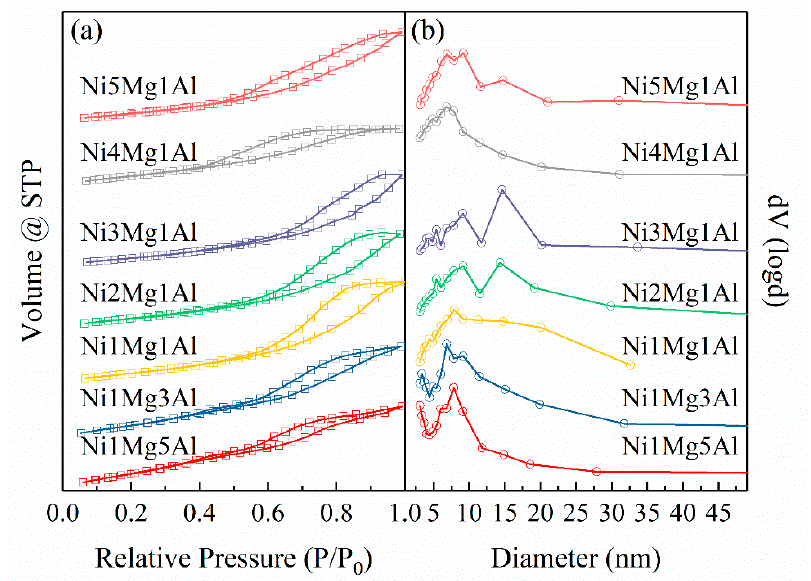
Figure 4. ( a ) N 2 adsorption isotherms performed at − 196 °C and ( b ) corresponding pore size distributions of the samples with different Mg/Al molar ratio.